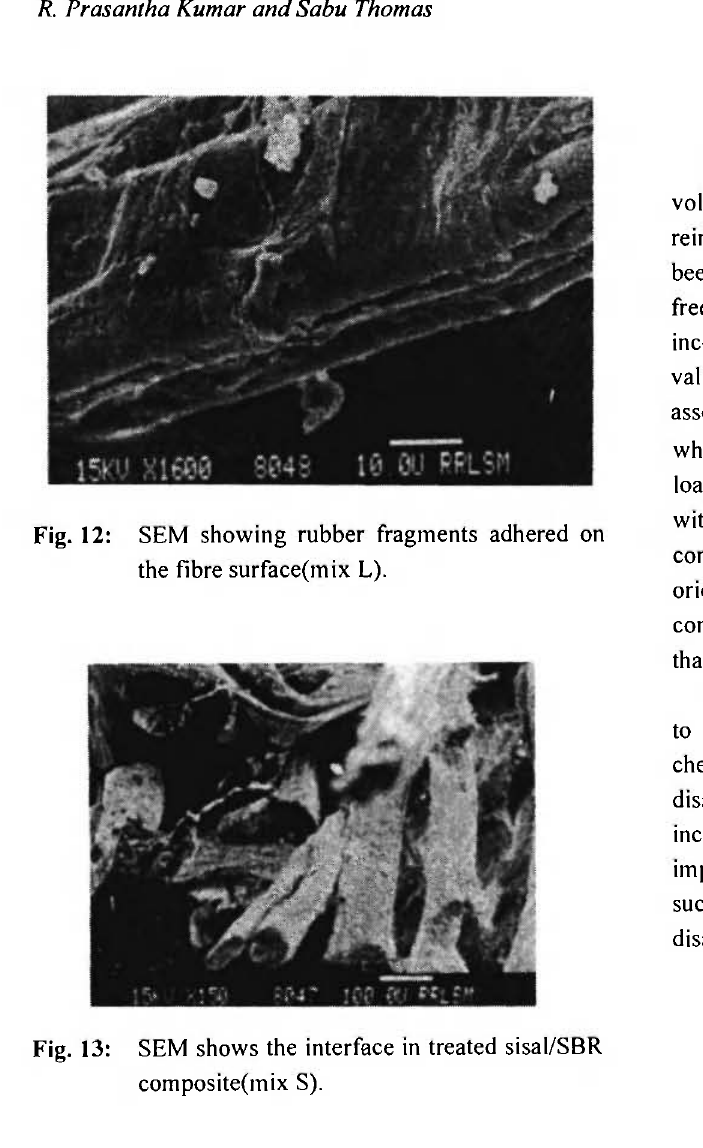
Fig. 13: SEM shows the interface in treated sisal/SBR composite(mix